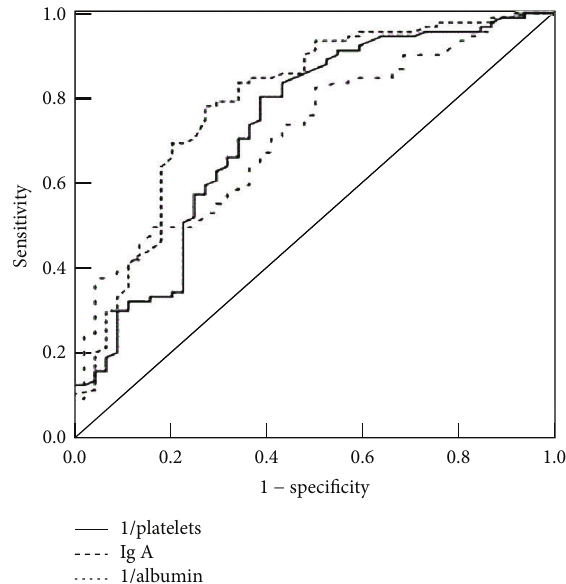
Figure 2: Liver cirrhosis prediction efficiency by 1/platelets, 1/albu- min, and IgA. Data are plotted as receiver operating characteristic